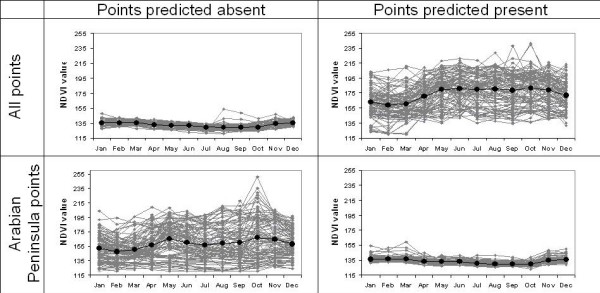
Summary of Normalized Difference Vegetation Index (NDVI) 'greenness' profiles of the Middle East and northeastern Africa through one year for models based on the entire region (top) and for models based only on the Arabian Peninsula. In each case, we show NDVI values for 100 randomly selected points of predicted absence versus 100 randomly selected points of predicted presence. Median values are shown in bold.